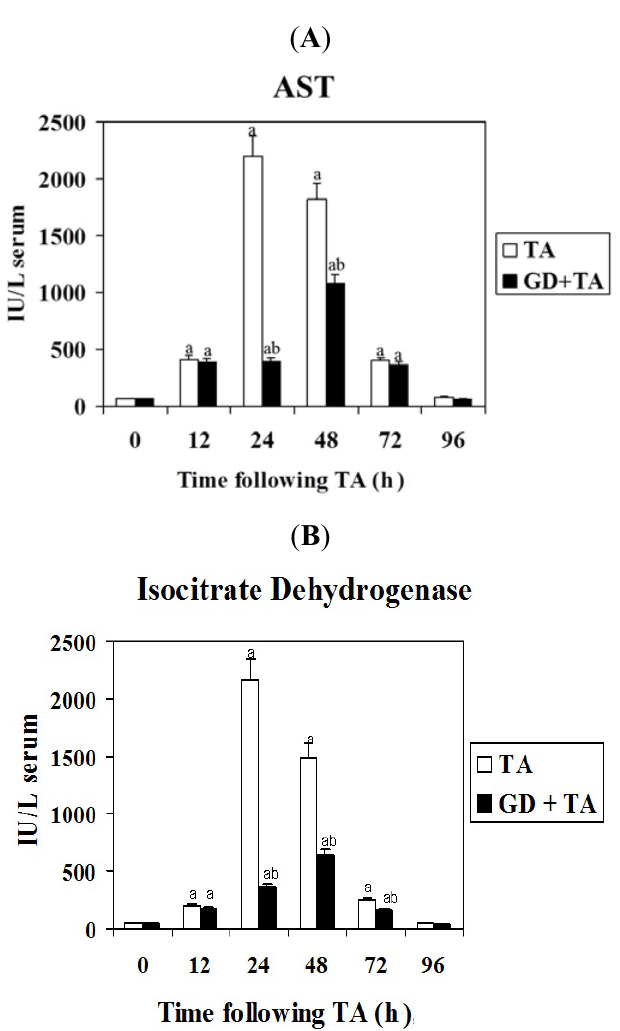
Figure 1. Effect of GD pre-treatment on aspartate aminotransferase ( A ) and isocitrate dehydrogenase ( B ) activities in serum of rats intoxicated with one sublethal dose of thioacetamide. Samples were obtained at 0, 12, 24, 48, 72 and 96 h following thioacetamide (TA). The results, expressed as IU/L of serum, are the mean ± SD of four determinations in duplicate from four rats. Differences against the respective control are expressed as (a) and differences due to GD are expressed as (b), P < 0.05.